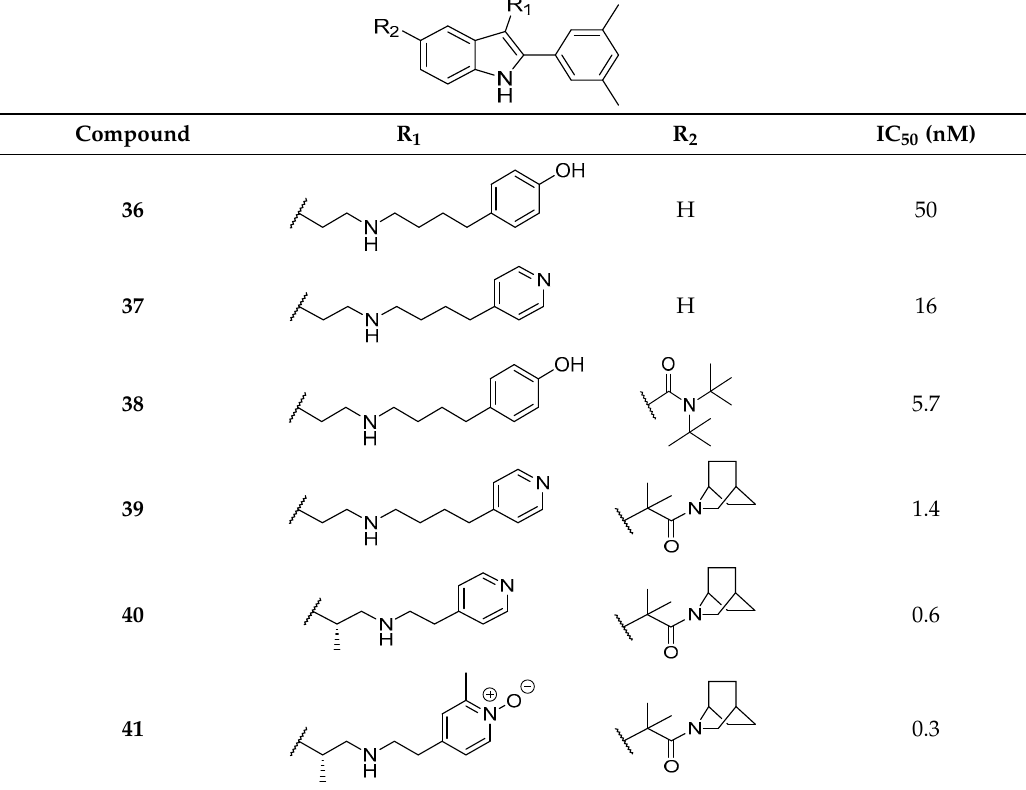
Table 7. Indole derivatives and their binding affinity at human GnRH-R.